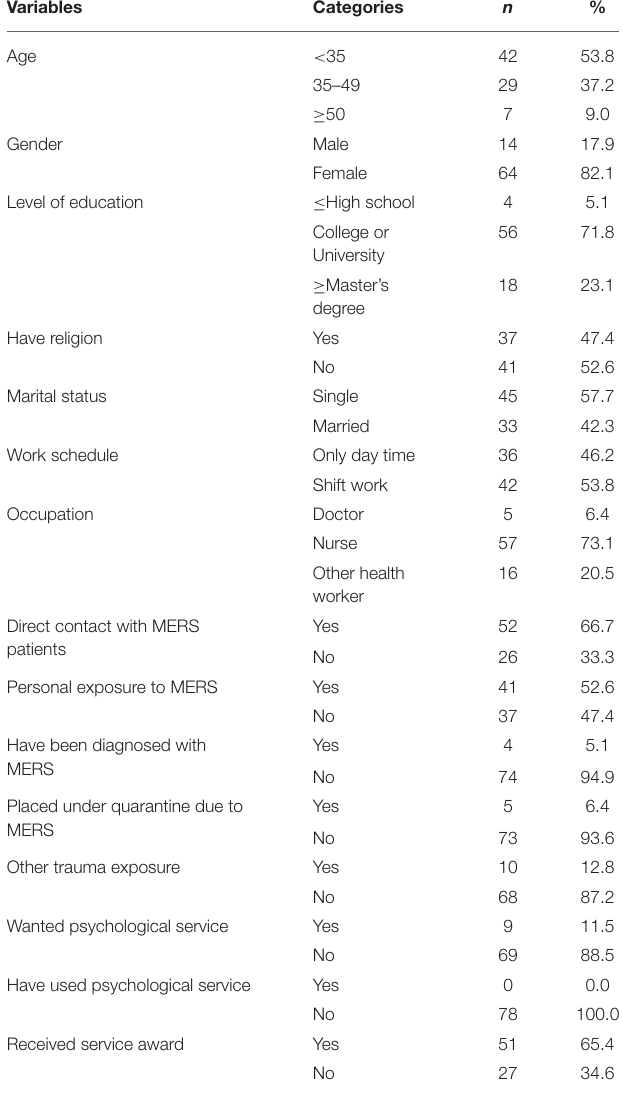
TABLE 2 | General characteristics of participants ( N =